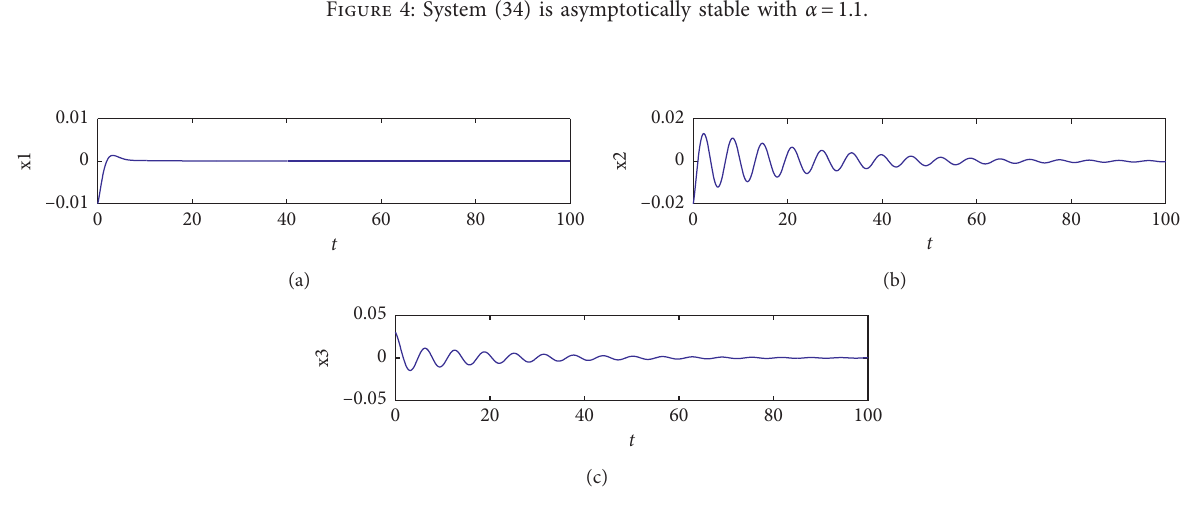
Figure 5: System (34) is asymptotically stable with α � 1.3.